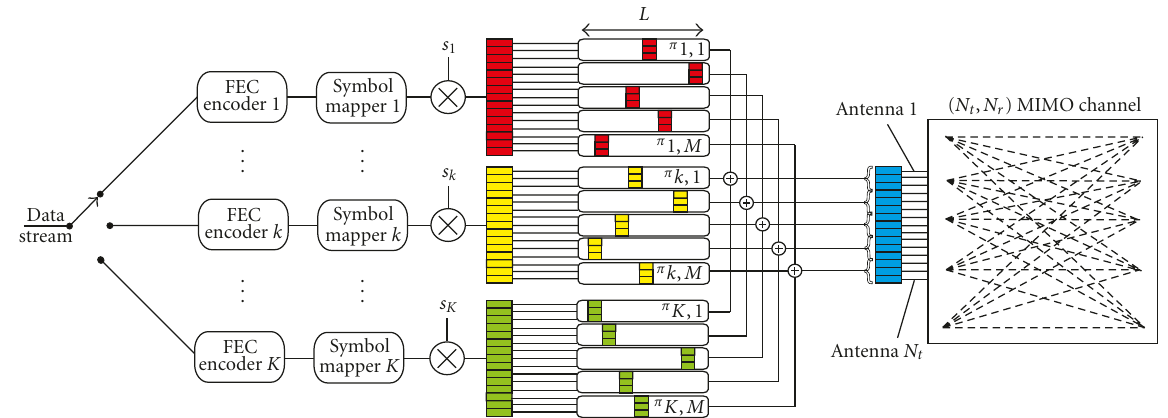
Figure 1: Strucutre of the proposed partitioned MIMO